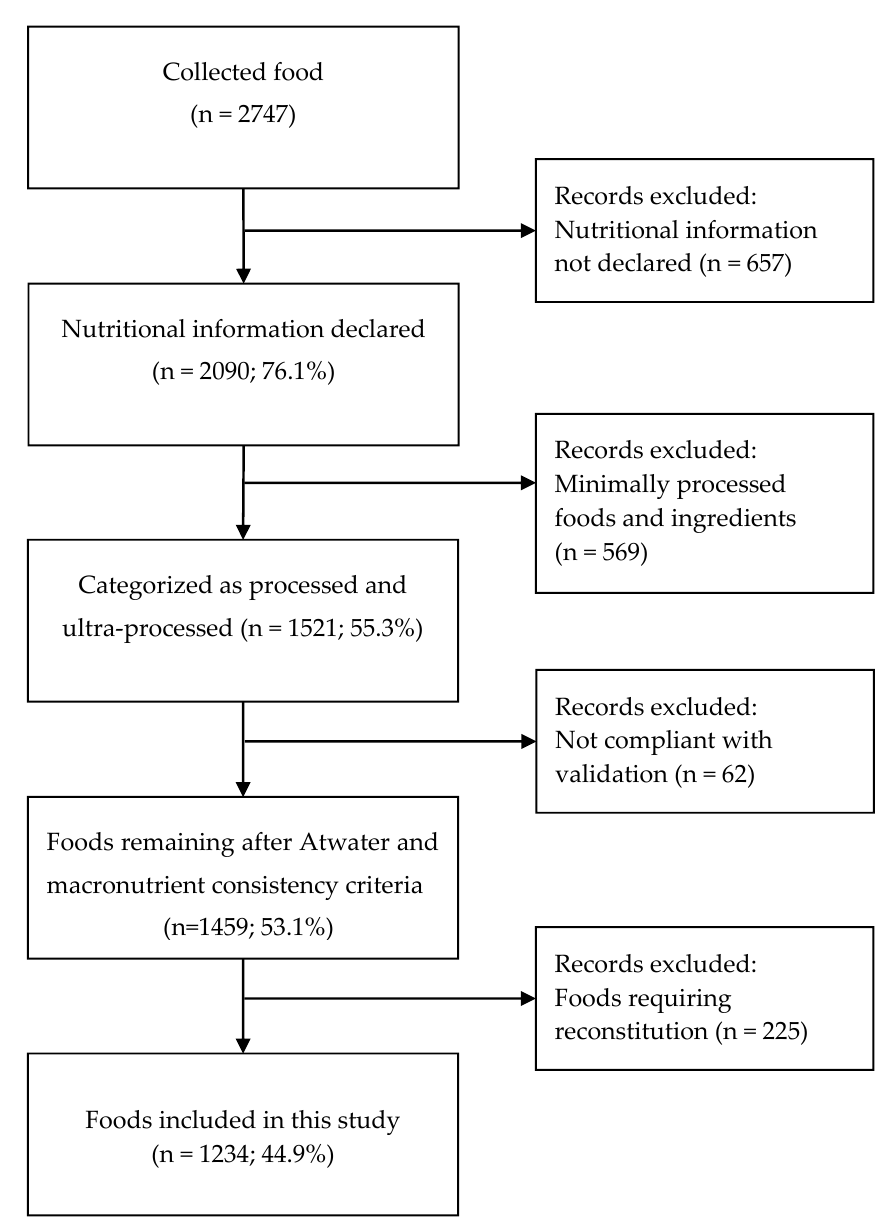
Figure 1. Sample selection flowchart.